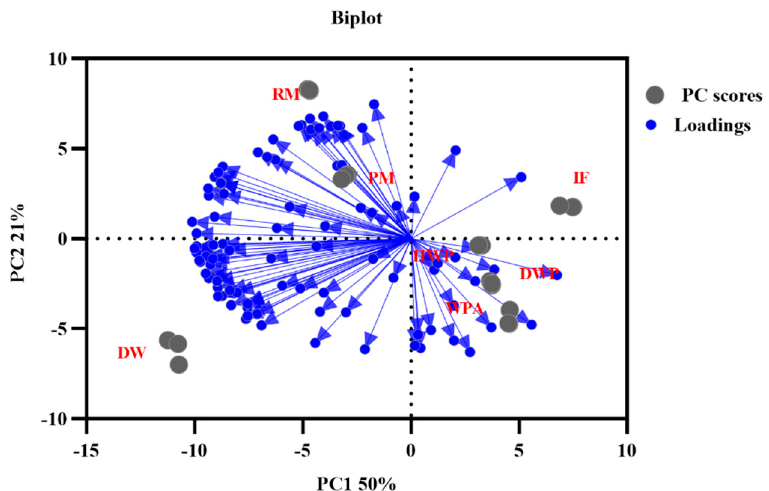
Figure 3. Principal component analysis (PCA) and different variance loading plots according to the quantitative results. RM, raw milk; PM, pasteurized milk; DW, demineralized whey; DWP, demineralized whey powder; HWP, hydrolyzed whey protein powder; WPA, whey protein powder with added alpha-lactalbumin; IF, infant formula.